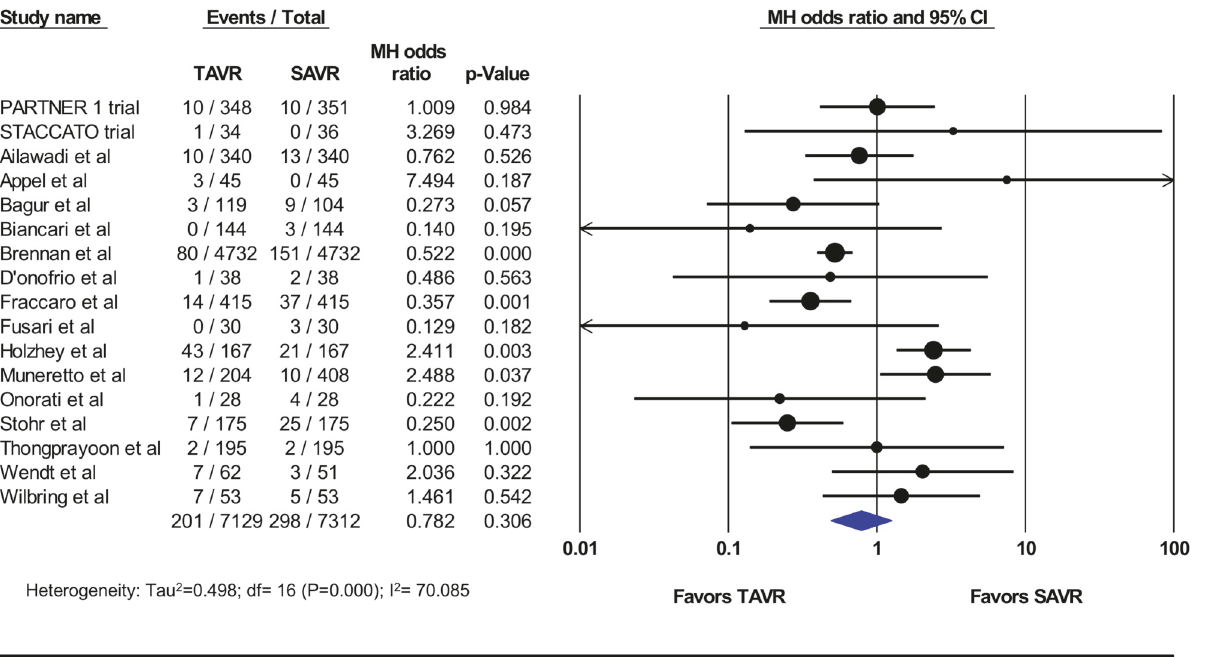
Figure 3: Pooled effect estimates for 30-day renal replacement therapy according to the type of aortic valve replacement procedure. TAVR: transcatheter aortic valve replacement, SAVR: surgical aortic valve